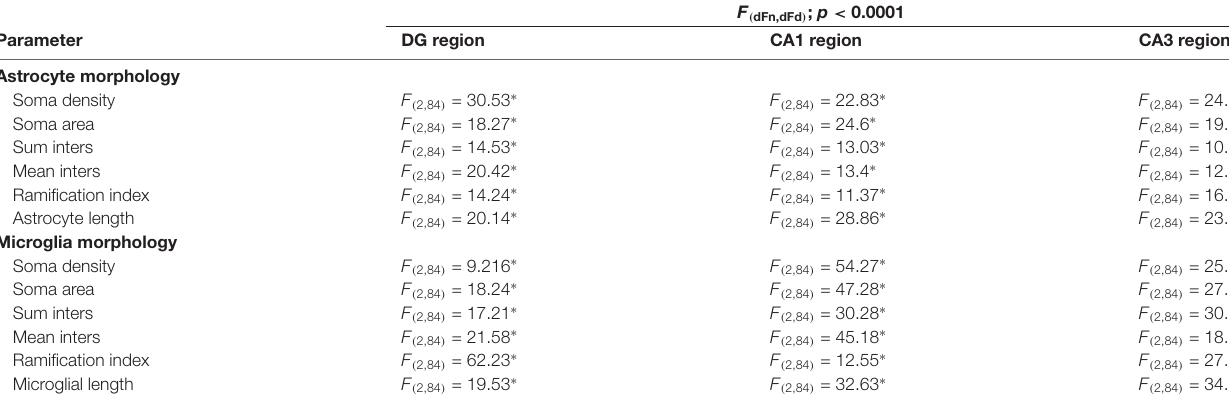
TABLE 1 | Astrocyte and microglia morphology during sleep deprivation (SD) and caffeine/modafinil administration.